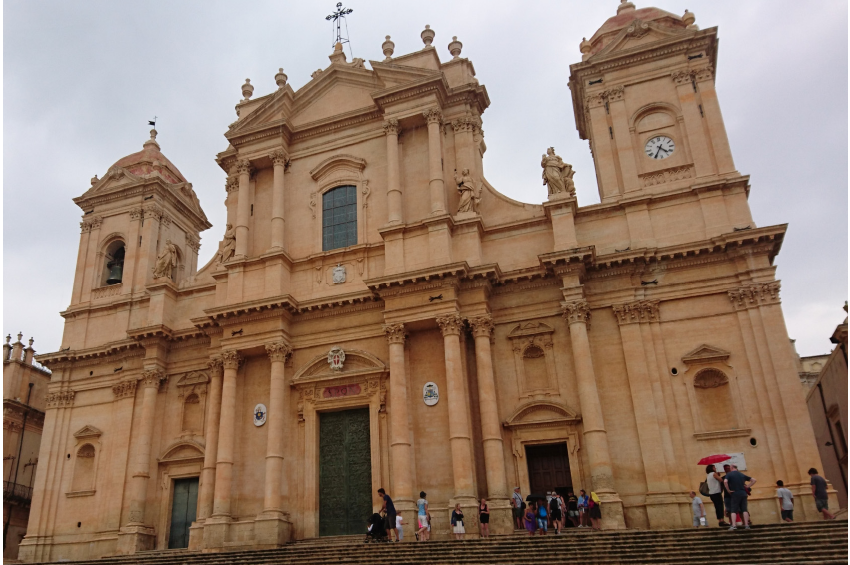
Figure 4. Monochromatic façade of the cathedral of Noto. Photo from private collection.